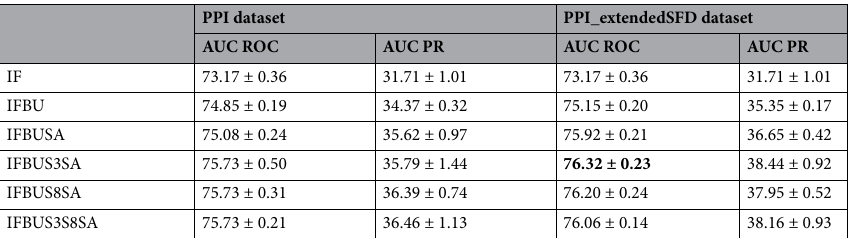
Table 2. Comparison of the PPI interface performance of the single-task model against different multi- task models. The mean AUC ROC and AUC PR scores and the corresponding standard deviations, on the validation set after training the models four times, are shown. Performance is measured on the validation set of both the PPI dataset and the augmented PPI_extendedSFD dataset. The multi-task models outperform the single task model (73.17 ± 0.36 AUC ROC) significantly on both dataset (P < 0.001). The overall highest AUC ROC score (76.32 ± 0.23), shown in bold, is reached when including buried residues, secondary structure in three classes and absolute solvent accessibility as related prediction tasks in addition to the PPI interface prediction on the PPI_extendedSFD dataset.